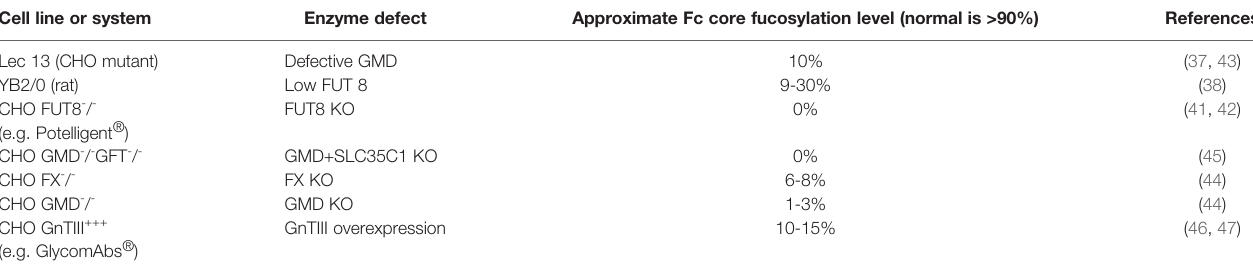
TABLE 1 | Examples of cell lines and strategies developed for low fucose antibody production. Cell line or